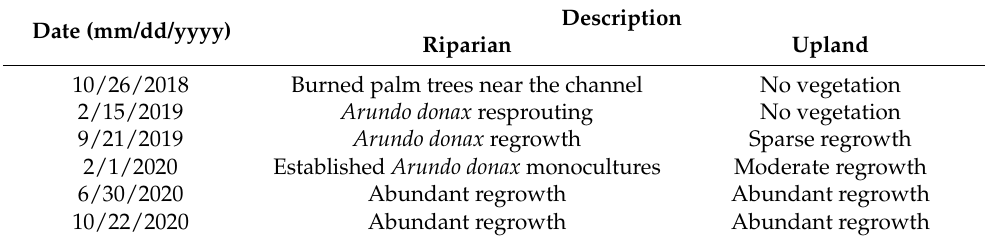
Table 1. Sampling dates and location